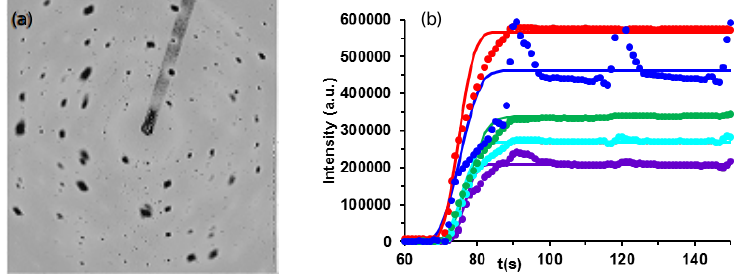
Figure 2. Analysis of individual crystallite TtXRD data for a T iso = 243 K experiment. ( a ) 2-D diffraction image; ( b ) Time dependent evolution of the intensity of representative spots with intensity above a threshold of 200,000 counts fit to their corresponding KJMA functions. The periodic spikes in intensity, even after the sample is fully crystallized, is an aliasing artifact resulting from the shutter and sample oscillation frequency being slightly out of synchronization.